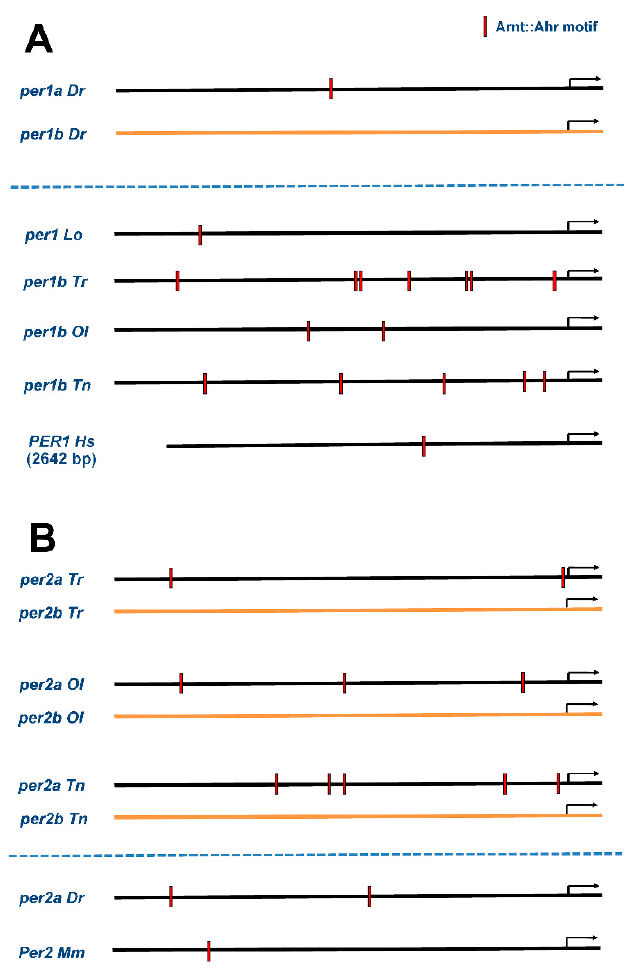
Figure 5. The transcription factor binding element (Ahr::Arnt) in upstream regions of duplicated Per genes from spotted gar to mammals. The complementary presence of the Ahr::Arnt motif in duplicated Per1 ( A ) or Per2 ( B ) paralog genes provides possible cases predicted by the duplication-degeneration-complementation (DDC) model. The upstream region of each gene is 3000 bp in length, with the exception of that of human PER1 , which is 2642 bp only. The transcription factor binding elements were predicted using the JASPAR dataset, with a profile score threshold of 99%. The bisque line represents duplication in the lineage, and the dotted line separates the duplicated genes and unduplicated genes.